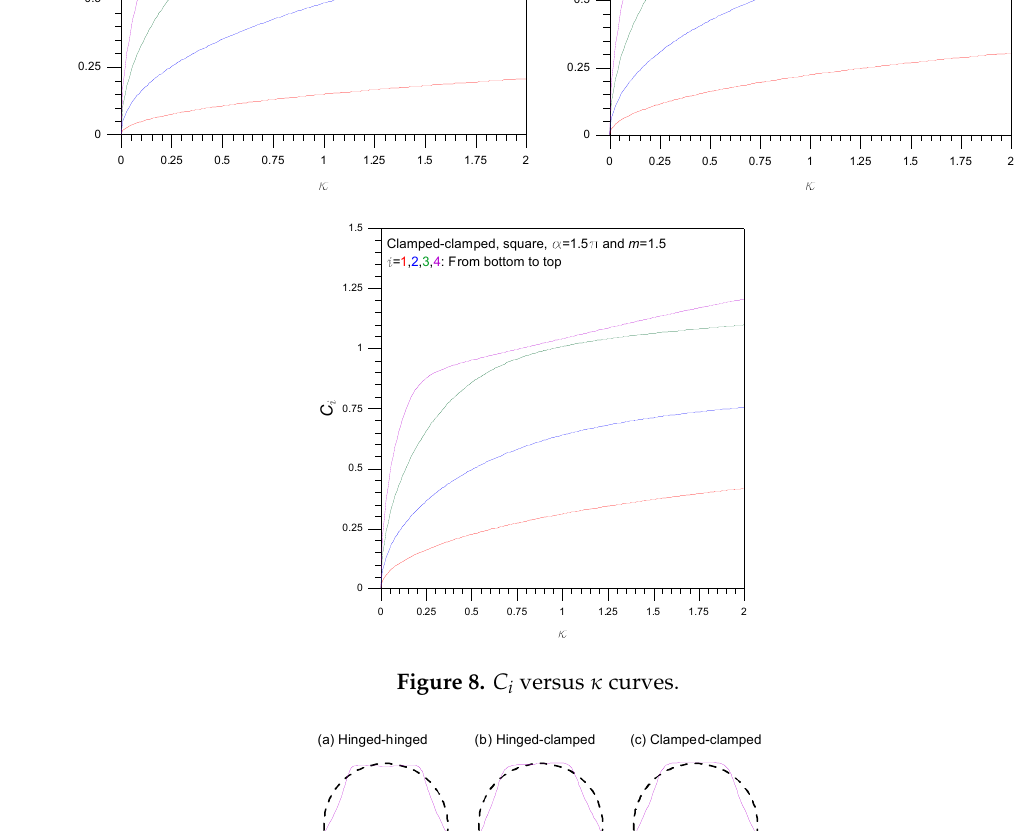
κ curves. i versus